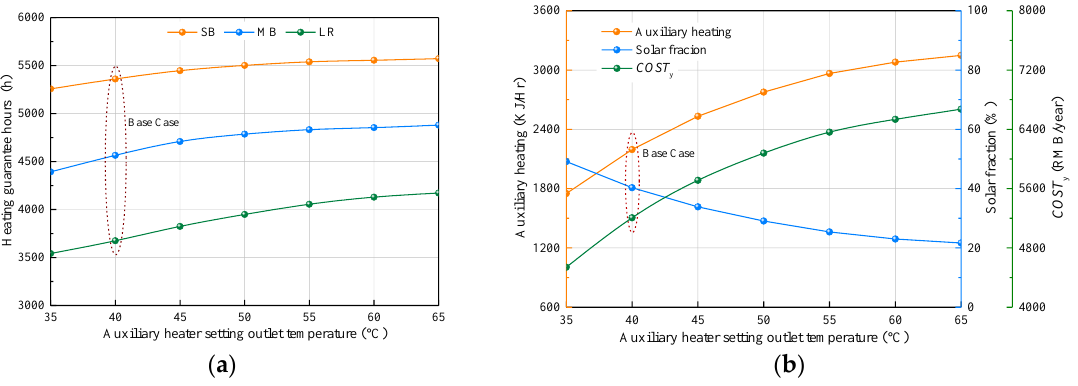
Figure 10. Optimized analysis of auxiliary heater setting outlet temperature. ( a ) Heating effect; ( b ) system performance evaluation.